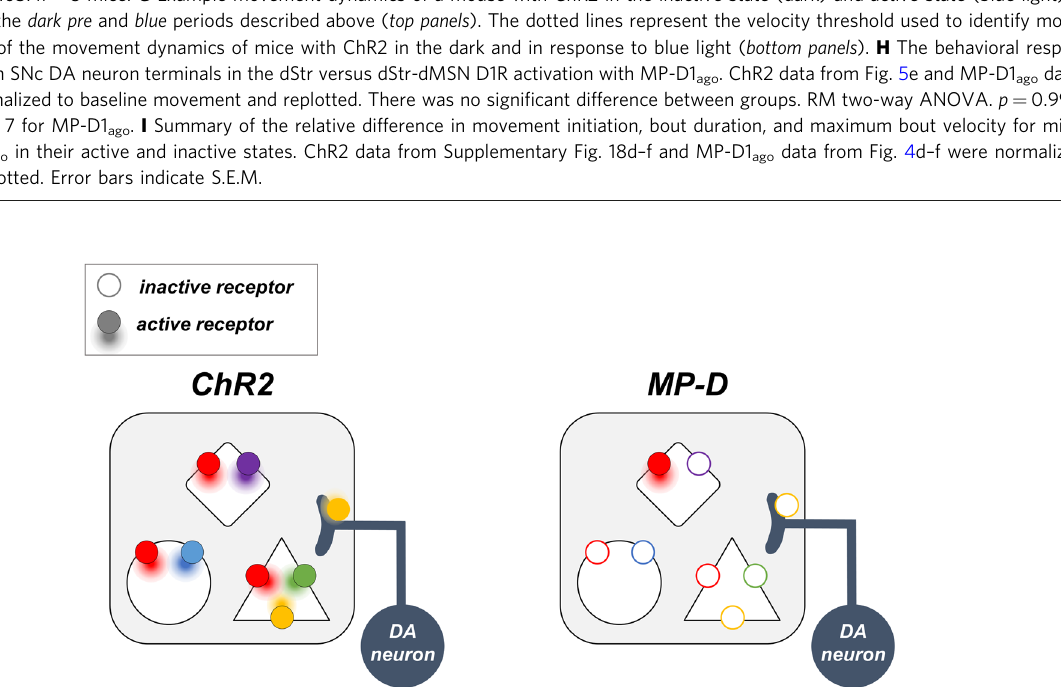
Fig. 6 Comparison of the effect of an excitatory opsin and MP on dopamine circuits. The excitation of dopaminergic neurons with ChR2 enhances neurotransmitter release onto the target brain area, resulting in the activation of multiple receptors in various combinations in multiple cell types (left panel). In contrast, an MP can be used to activate just one of the targets of those neurons (right panel). Each color represents a particular receptor